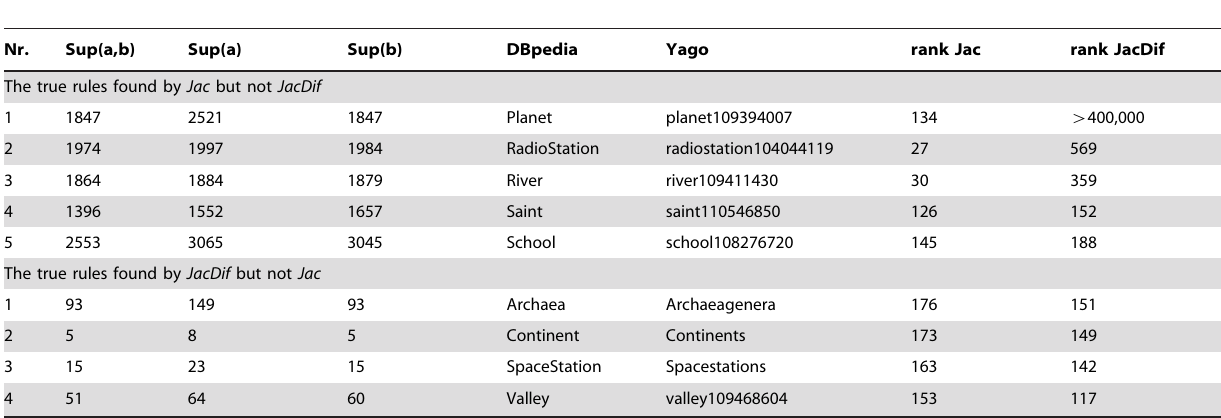
Table 7. Difference in the true rules sets of Jac and JacDif for the DBpedia-Yago dataset.